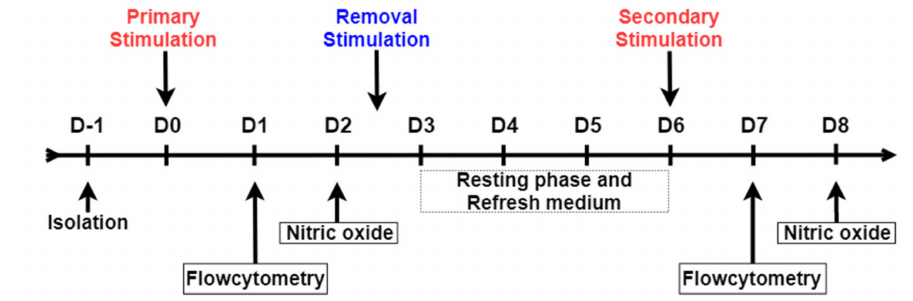
Figure 1. Schematic overview of the in vitro model for trained innate immunity. Adherent cells were primary stimulated with culture medium (UNSTIM), lipopolysaccharide (LPS), β -glucan